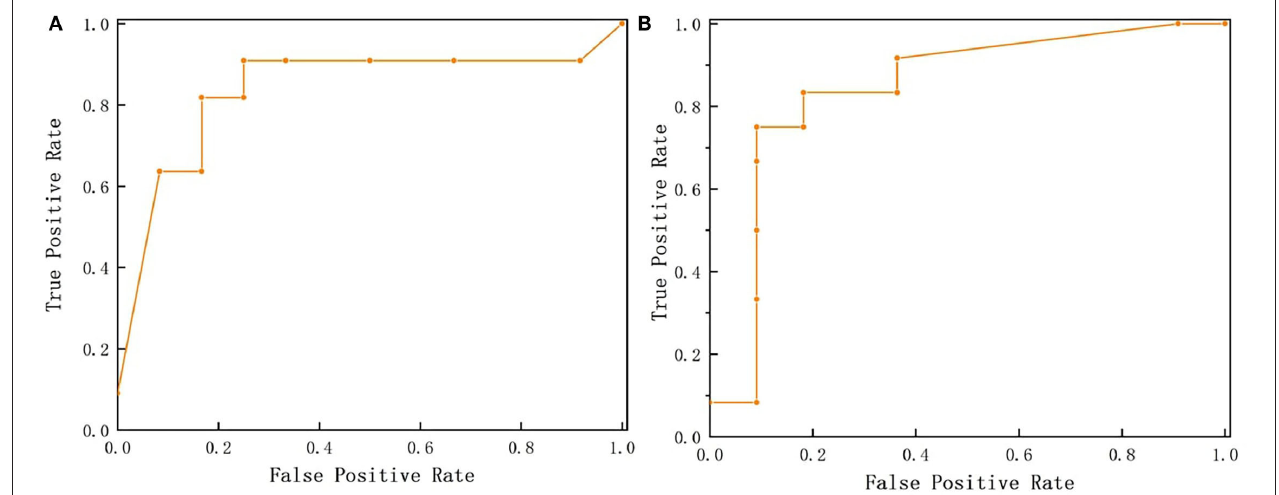
FIGURE 5 | Receiver Operating Characteristic (ROC) curves. (A) is ROC curve of positive samples (SSC beyond 9 Brix) while (B) is ROC curve of negative samples (SSC below 9 Brix). performance than the model based on CARS, with the